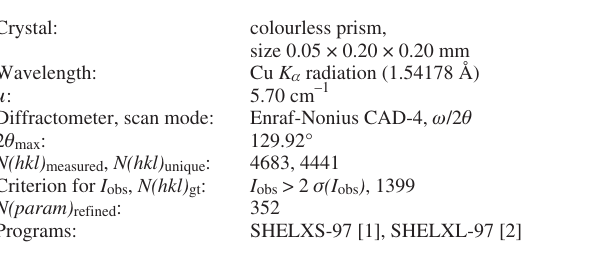
Table 1. Data collection and handling.